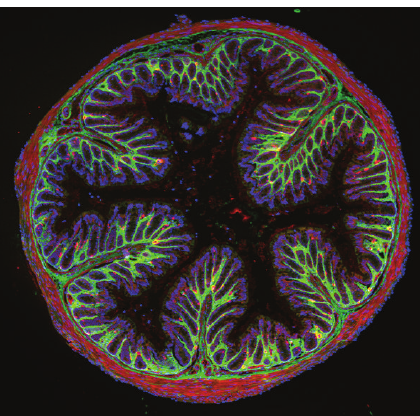
Figure 1: Hyaluronan is a normal component of the large intestine. Cross-section of the distal colon from a healthy mouse, fixed and stained for HA [8] (using biotinylated HA binding protein and a fluorescent detection reagent, green), shows normal deposition around the epithelial-lined crypts. Muscle cells are stained red and cell nuclei are stained blue.